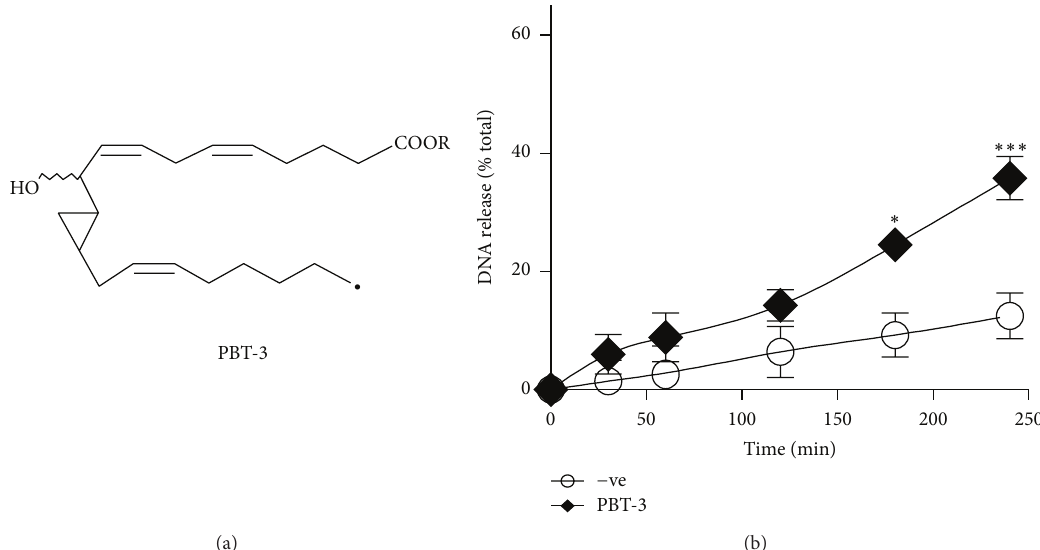
Figure 3: PBT-3 induces DNA release from human neutrophils. (a) Structure of PBT-3. (b) Neutrophils were seeded into 96-well plates in the presence or absence of PBT-3 (20 𝜇 g/mL), and the extracellular DNA release was monitored using Sytox Green cell impermeable DNA dye. The results show a time-dependent increase in NET release after activation with PBT-3 (20 𝜇 g/mL) ( 𝑛 = 4 ). R = Methyl.